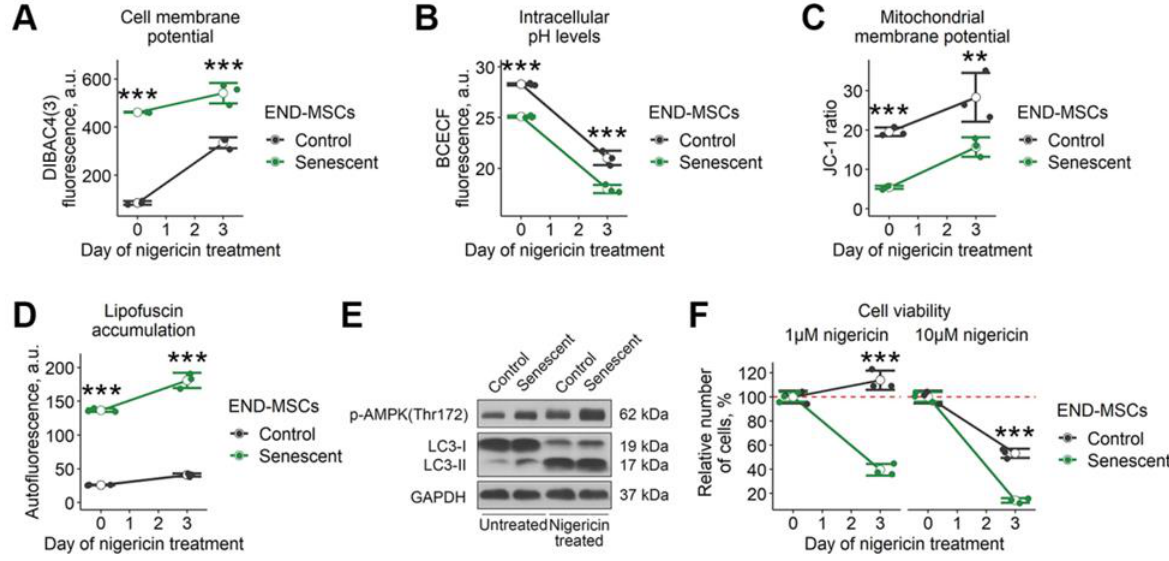
Figure 4. Nigericin treatment affects multiple cell homeostasis parameters and causes senolysis in END-MSCs. Nigericin treatment (10 μM) ( A ) diminished cell membrane potential, ( B ) lowered intracellular pH i levels, ( C ) increased mitochondrial membrane polarization, ( D ) stimulated lipofuscin accumulation, and ( E ) modulated autophagy dynamics in control and senescent END-MSCs. ( F ) Nigericin treatment induced cell death more intensely in senescent END-MSCs compared to control ones at different concentrations, with cell viability data presented as relative cell viability (%) of control and senescent END-MSCs 3 days after treatment. Values presented are mean ± s.d. For comparison of parameters and viability of control and senescent cells with treatment, two-way ANOVA with Tukey’s HSD was applied, n = 3, ns—not significant, ** p < 0.01, *** p < 0.005. Full-length blots are presented at Supplementary Figure S1D; GAPDH was used as loading